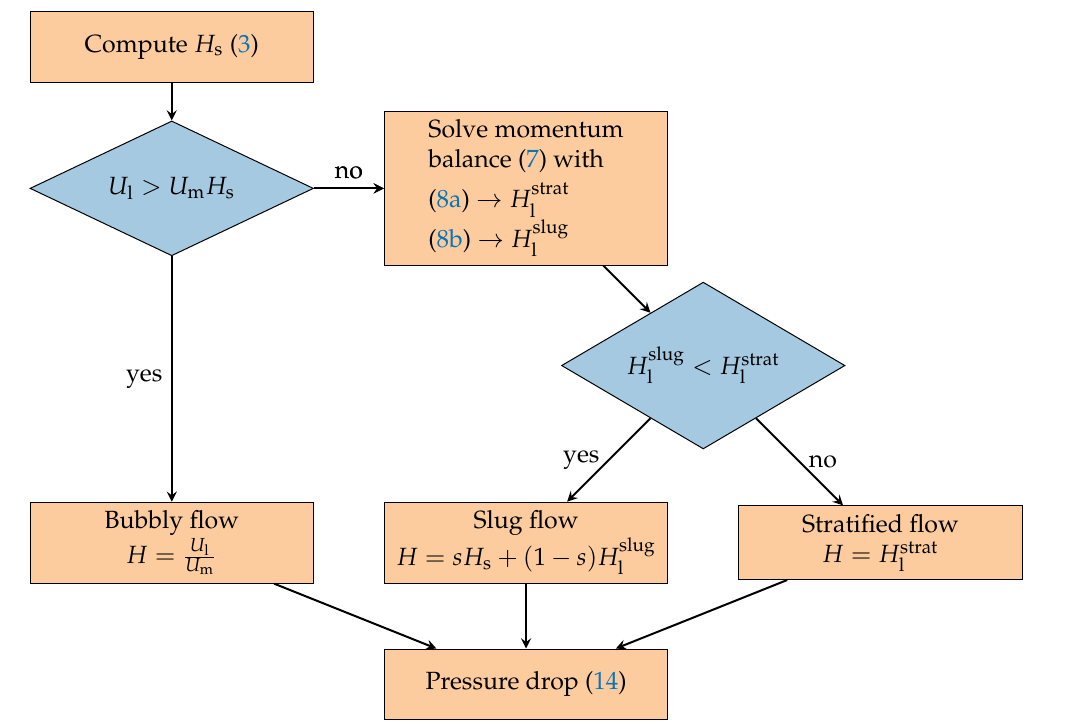
Figure 2. Flowchart of the point model. First holdup is computed, then pressure